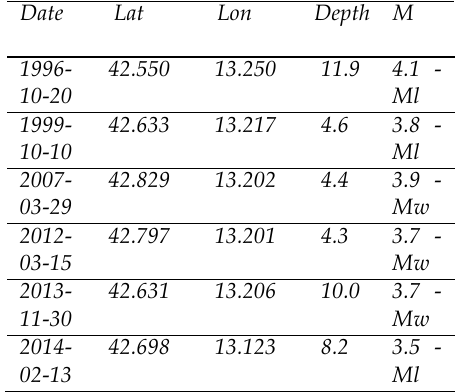
Table 1A . Data from INGV Catalogs: